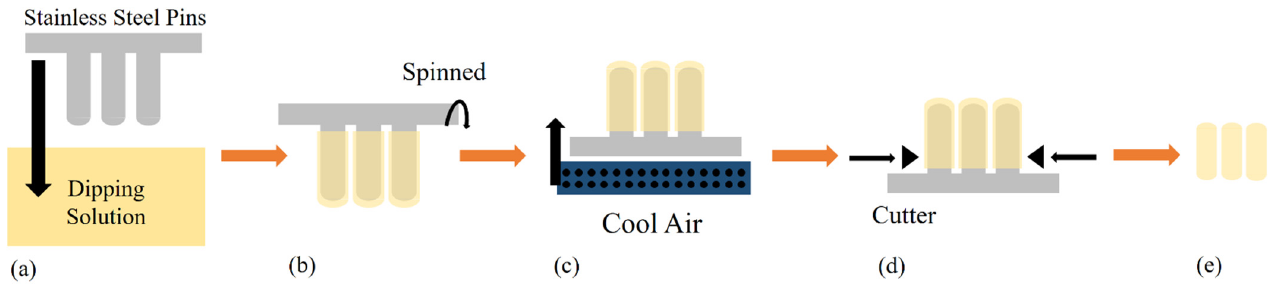
Figure 3. Hard-capsule production using the dipping method. ( a ) Dipping, ( b ) spinning, ( c ) blowing, ( d ) stripping and trimming and ( e ) joining.